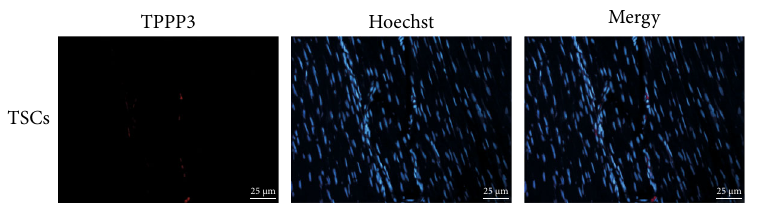
Figure 1: TSCs existed in tendon tissue were con fi rmed ( n = 3 ). Scale bar: 25 μ